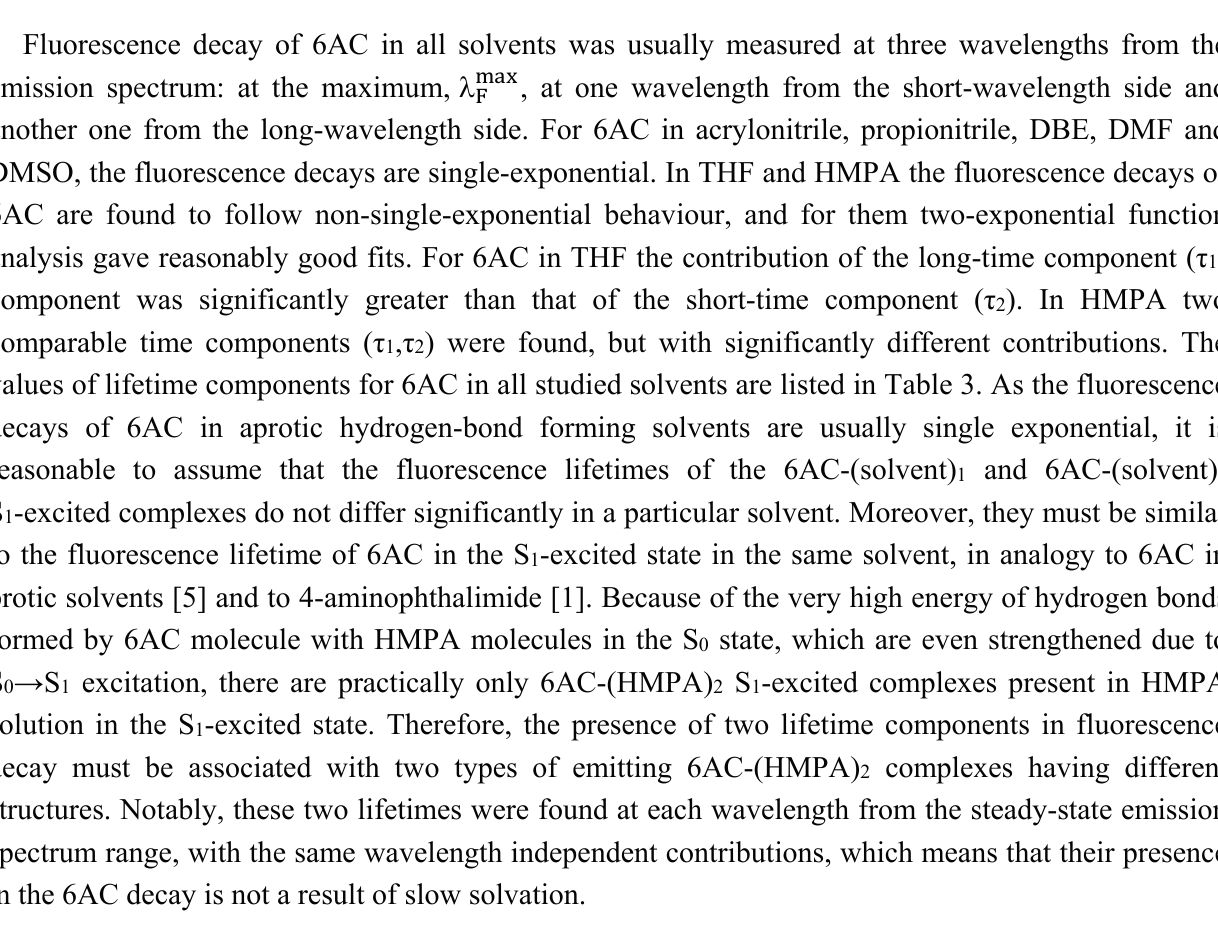
Table 3. Photophysical properties of 6AC in aprotic hydrogen-bond forming